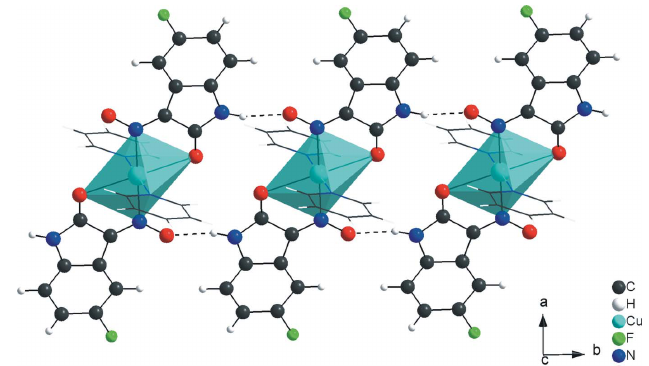
Figure 5 Partial crystal packing of the title compound, viewed along the c axis, showing the C—H (cid:2)(cid:2)(cid:2) O interactions (dashed lines) forming rings of R 2 (14) graph-set motif connecting the molecules into a chain along the 2 [010] direction.